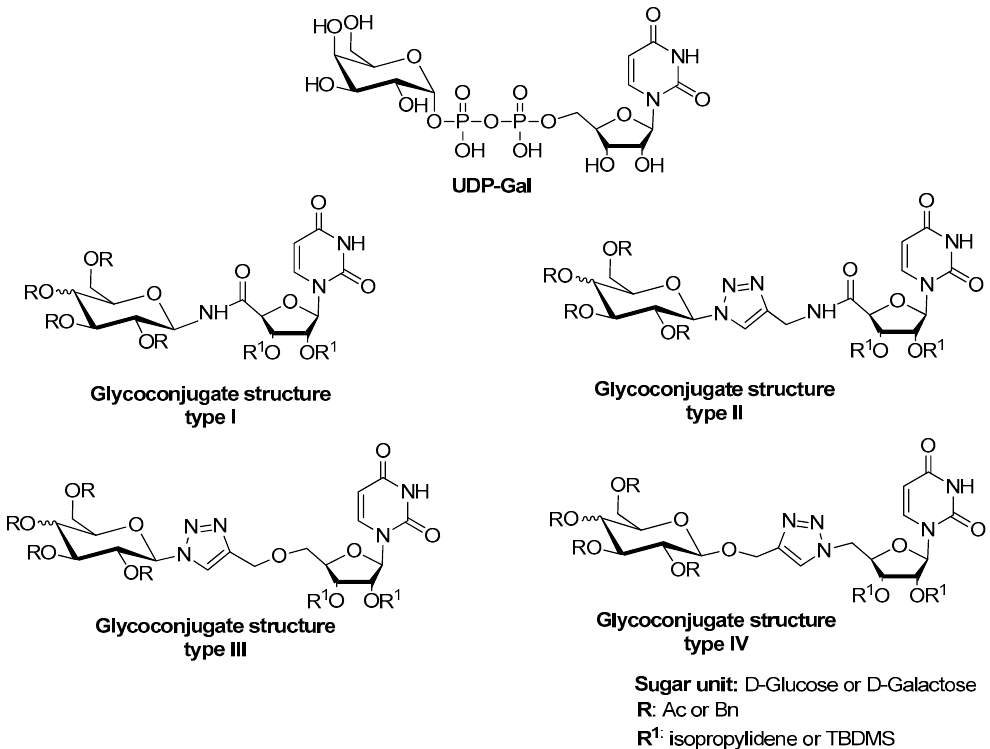
Figure 1. The general structures of glycoconjugates, analogues of the natural β 4GalT substrate—UDP- Gal.